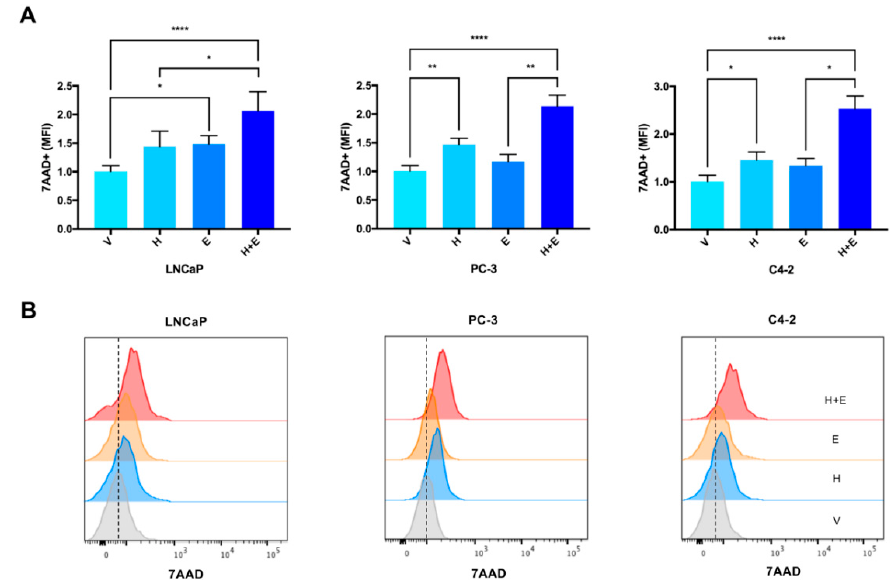
Figure 5. The combined treatment of hydralazine and enzalutamide induced an increase in the amount of 7AAD in PCa (prostate cancer) cells. Values were normalized to the vehicle condition ( A ). Corresponding histograms depicting the amount of 7AAD ( B ). (MFI—mean fluorescence intensity, V—vehicle, H—hydralazine, E—enzalutamide, H+E—combination of hydralazine and